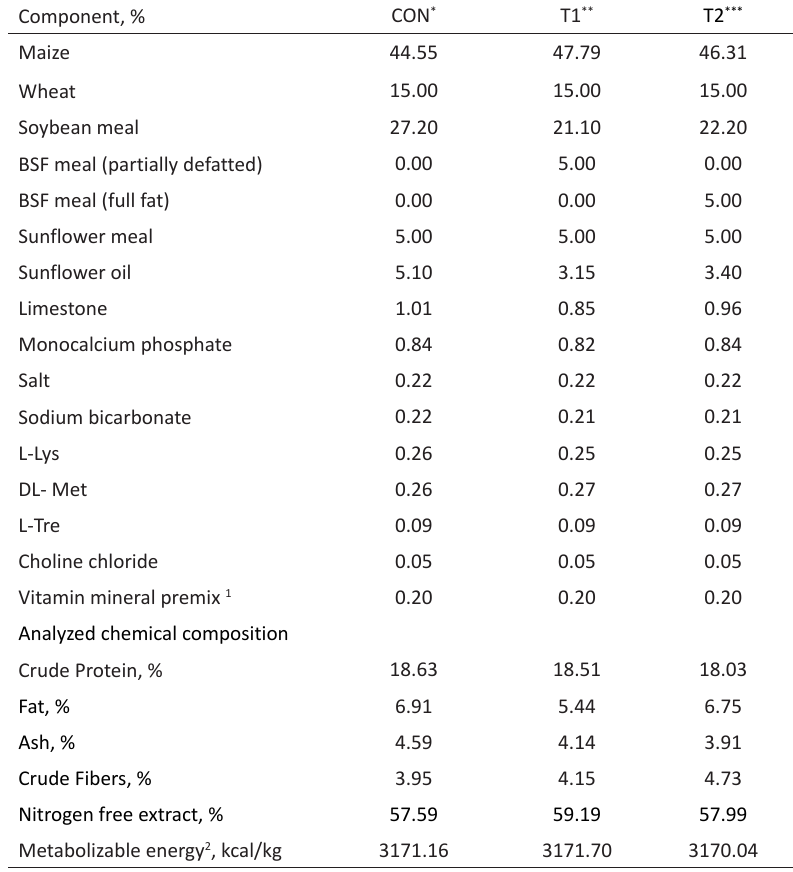
Table 1. Ingredient and chemical composition of the